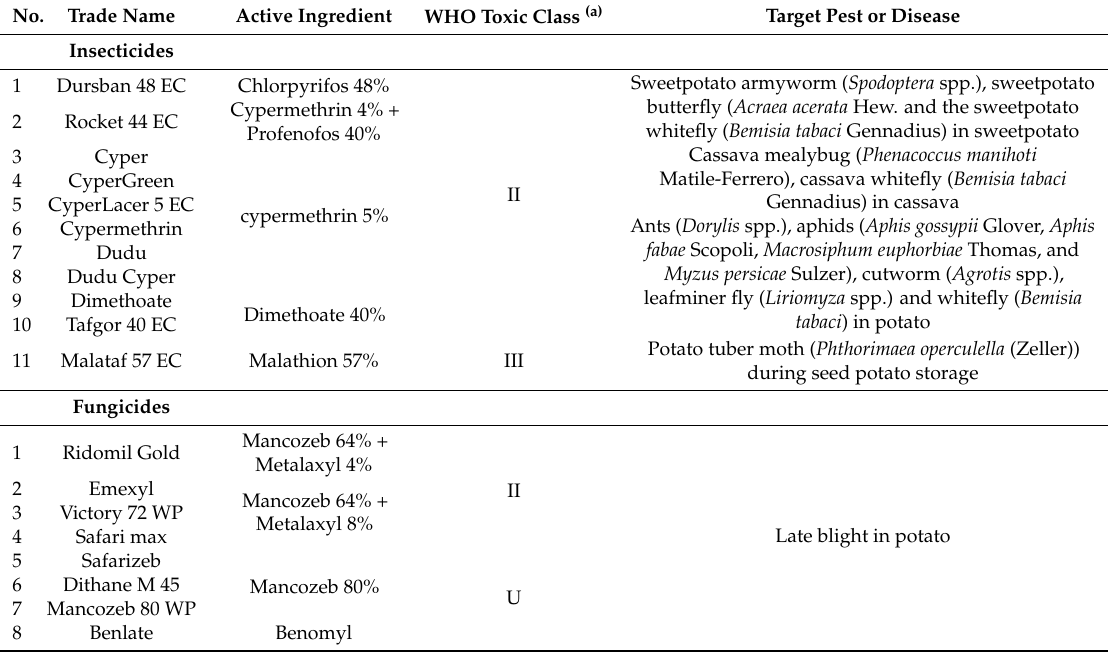
Table 1. Trade names, active ingredients, and WHO toxicity classes of pesticides used by farmers of root, tuber, and banana (RTB) crops in Rwanda and Burundi.